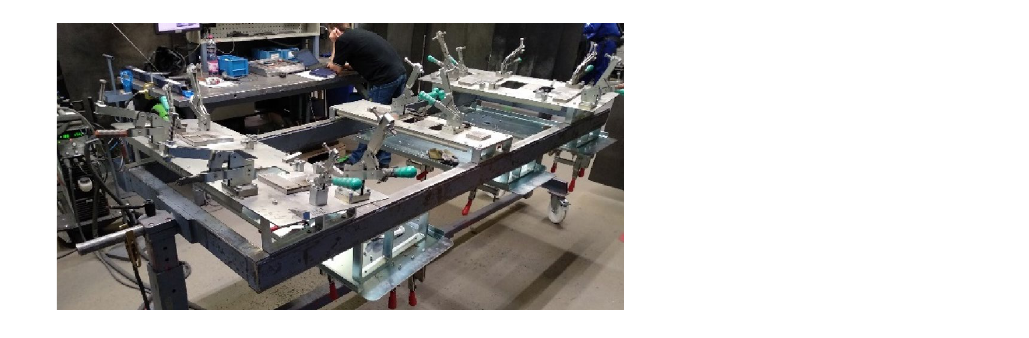
Figure 14. Welding jig for welding a door